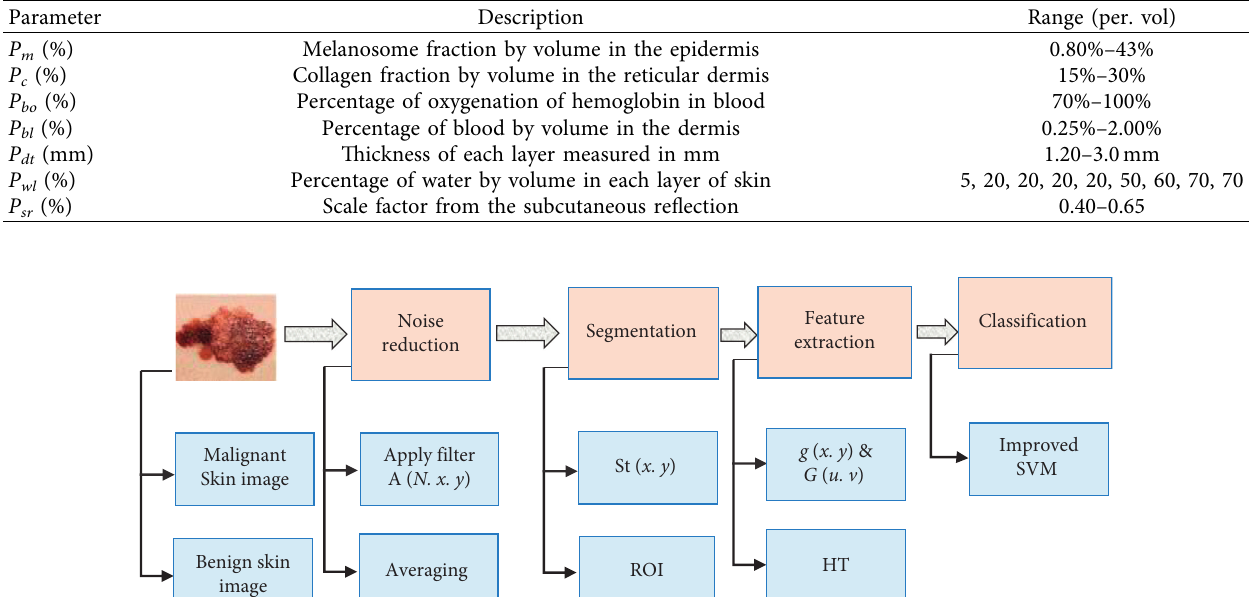
Table 1: Parameters and their descriptions with physiological range.